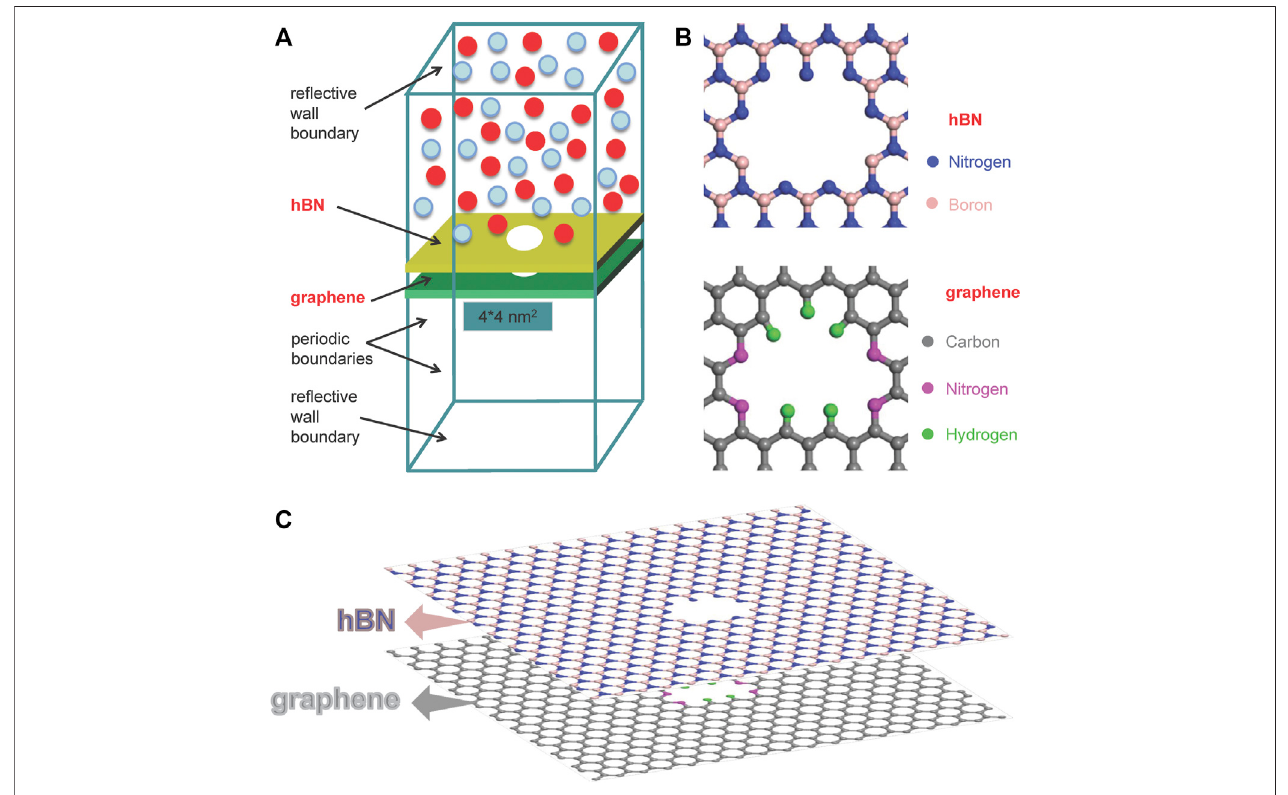
FIGURE 1 | Simulation model. (A) Non-equilibrium MD simulation system; (B) structure of the nanopore; (C) stacking of the graphene and hBN layers.